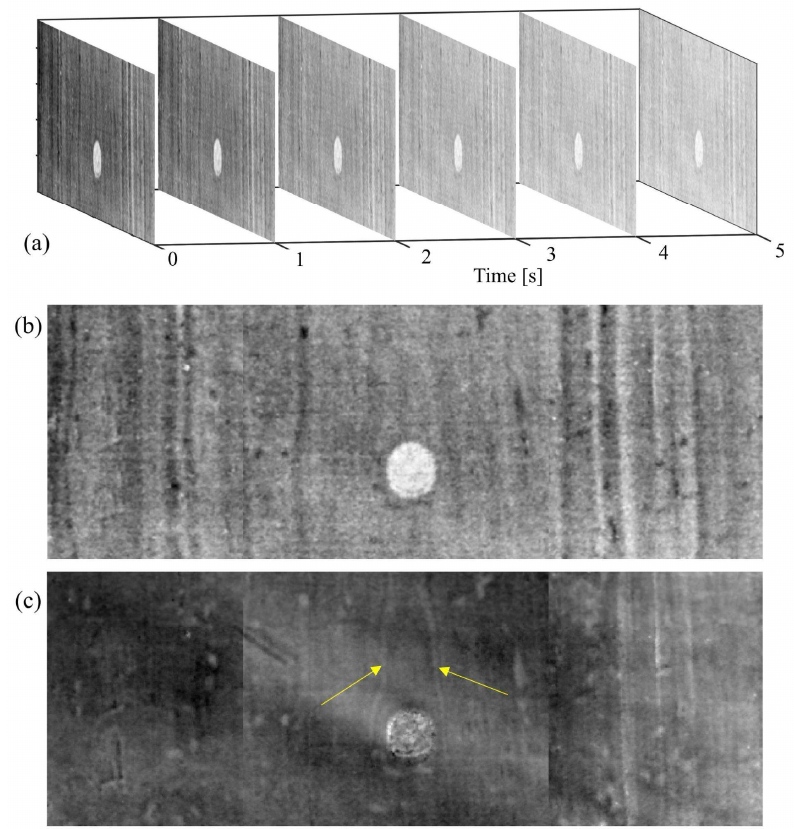
Figure 7. ( a ) a series of thermograms at different time instants acquired from the back panel surface using PuCT; ( b ) same as ( a ), but for a single t = 4 s; ( c ) image obtained using the time-phase feature, with yellow arrows pointing towards the wood grain surrounding the hollow